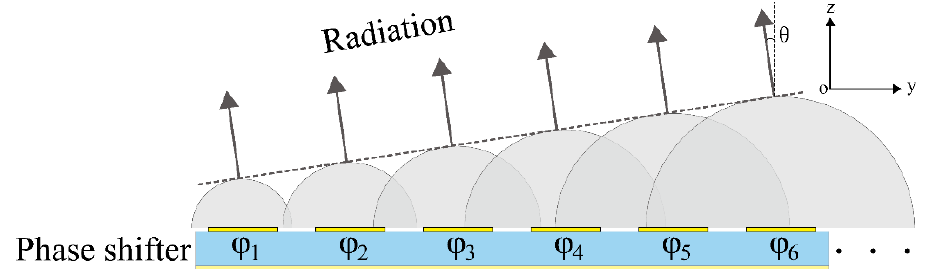
Figure 4. Operation principle of the reflectarray.